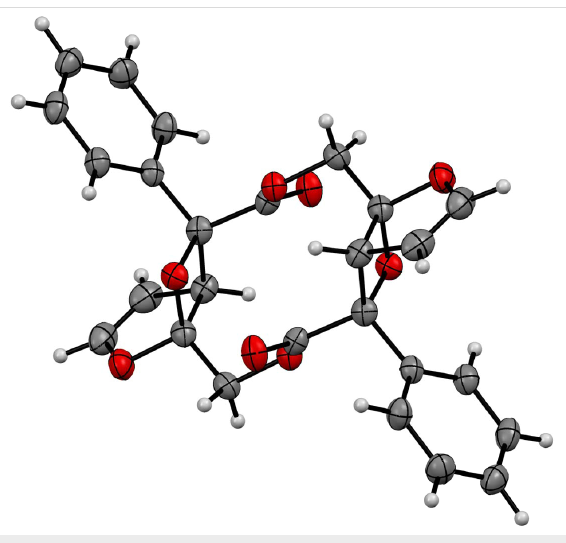
Figure 1: X-ray crystal structure of the macrocyclic lactone 2a